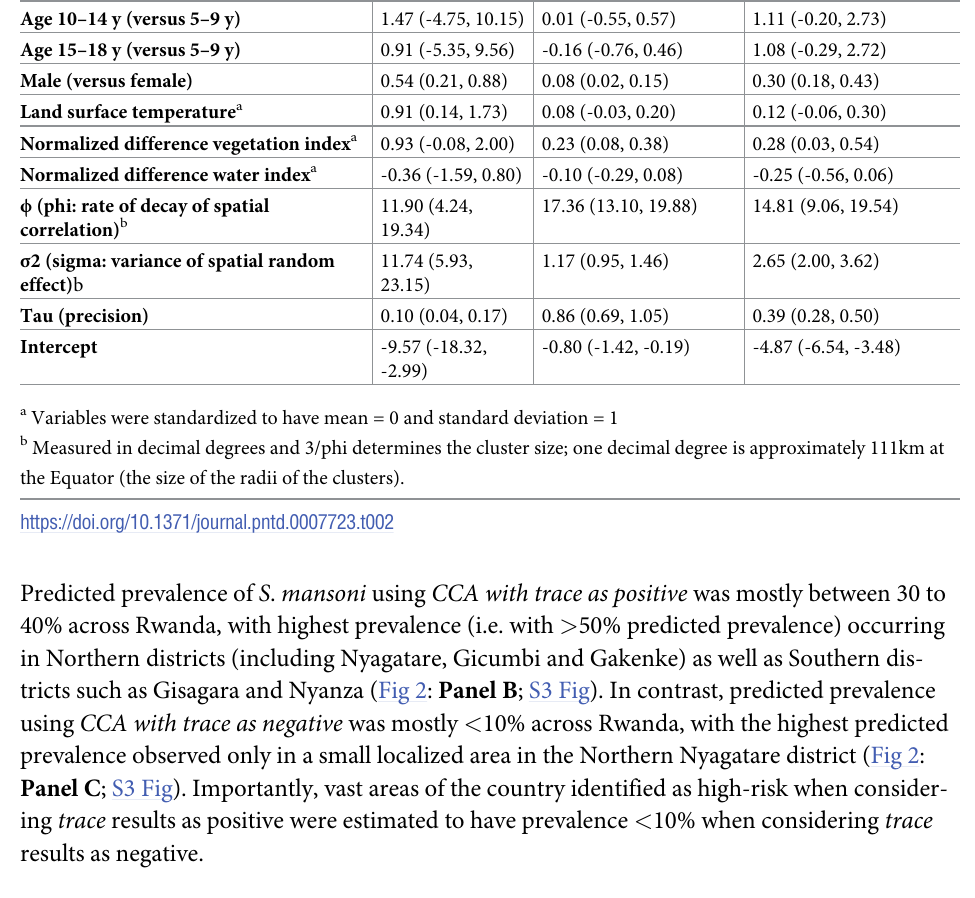
Table 2. Predictor associations with an individual child’s probability of being infected with Schistosoma mansoni , estimated using three different diagnostic methods to account for possible discrepancies in diagnostic perfor- mance and estimates of geographical endemicity. For each diagnostic method, a geostatistical model was built to estimate predictor effects while accounting for spatial autocorrelation. Presented are effect means and 95% credible intervals (in brackets). KK; Kato-Katz. CCA; Circulating Cathodic Antigen.